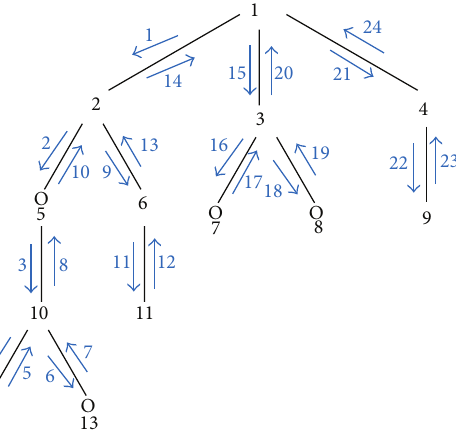
Figure 4: Process of generating the GBMD